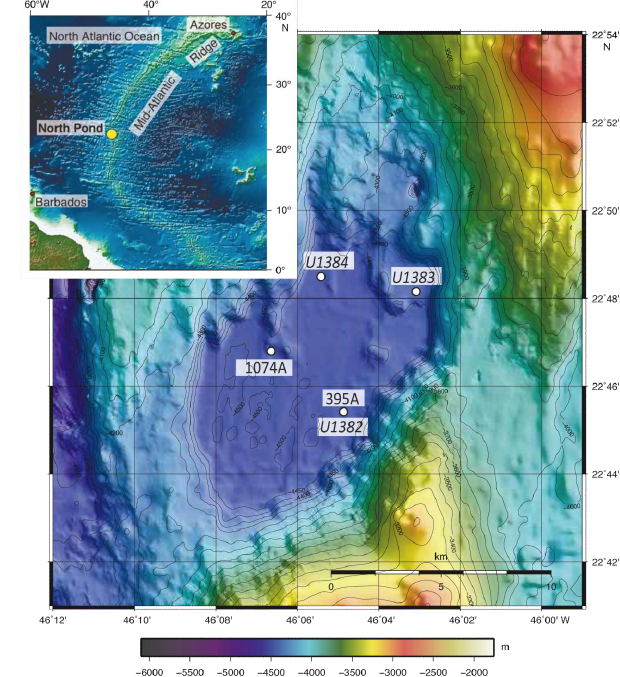
Figure 1. Bathymetric map of the North Pond area (data from Schmidt-Schierhorn et al., 2012) on the western flank of the Mid- Atlantic Ridge (see